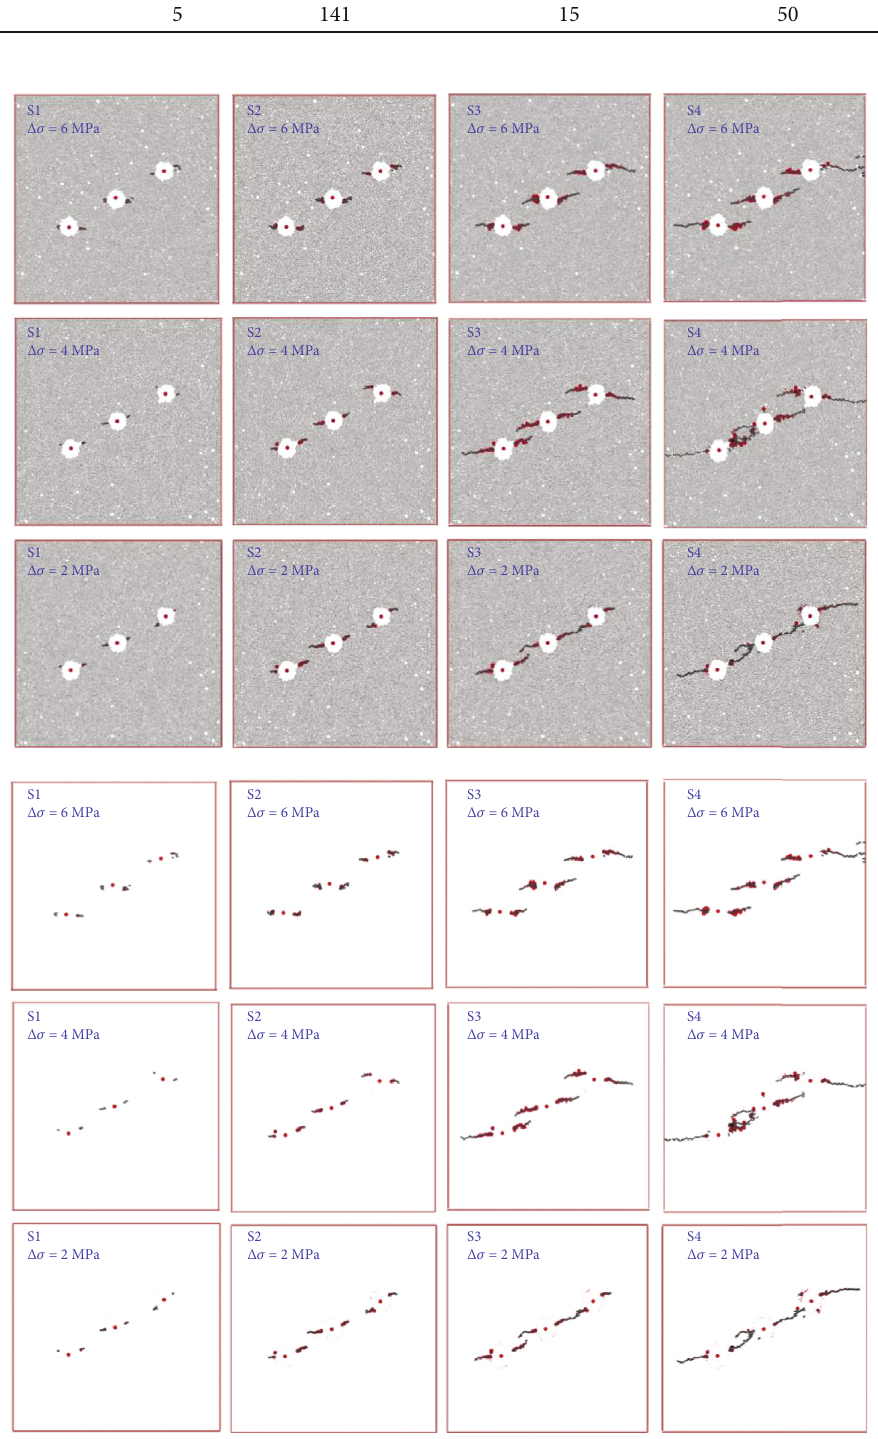
Figure 14: Initiation and propagation process of directional hydraulic fractures at di ff erent principle stress di ff